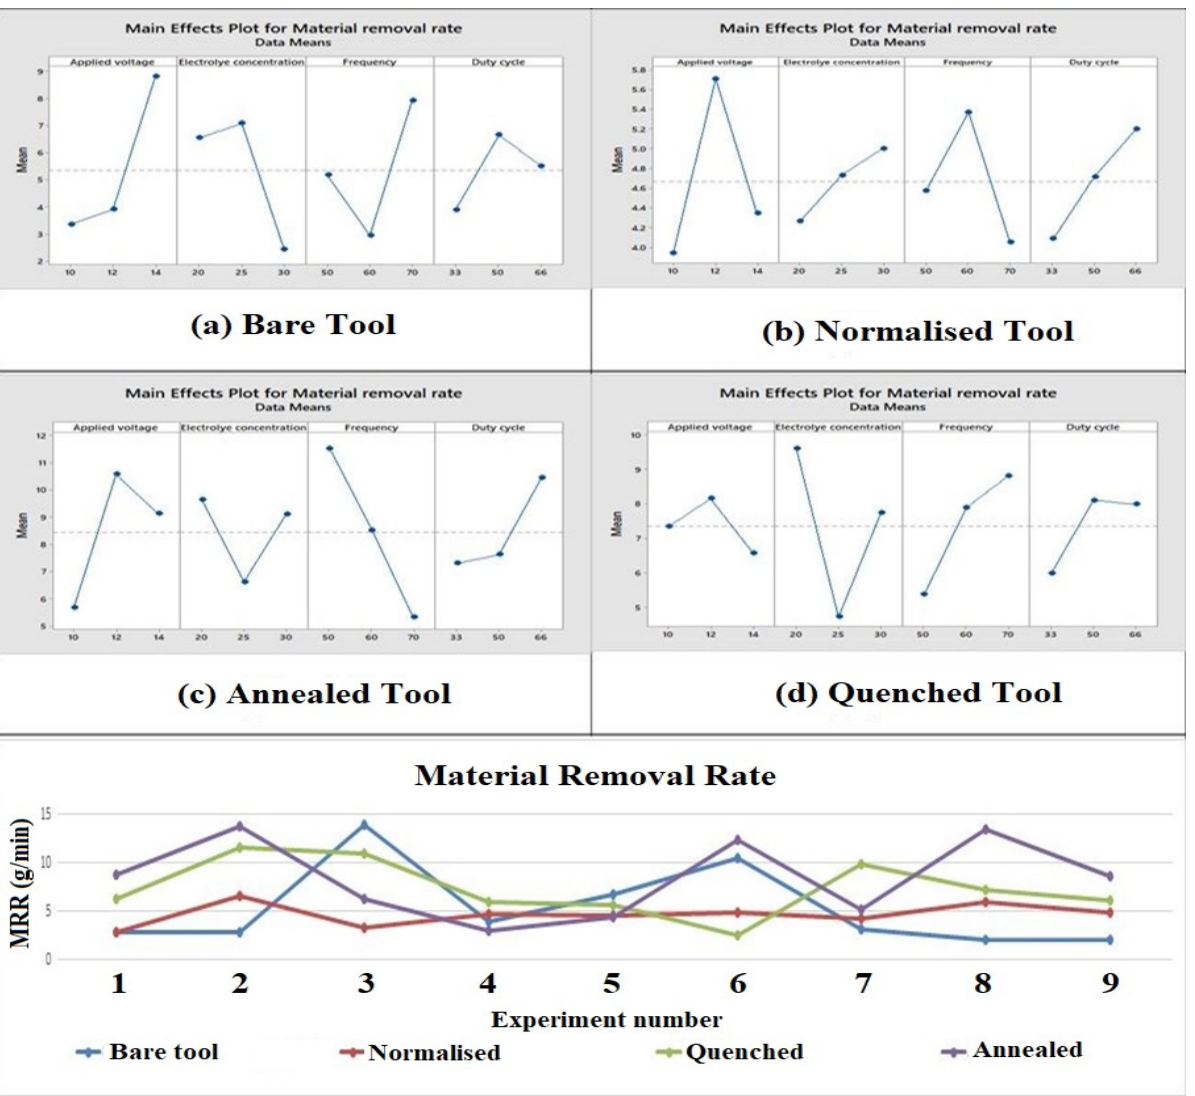
Figure 4. Main effect plots and comparison plot of MRR for tool electrodes. ( a ) Bare tool; ( b ) Normalized tool; ( c ) Annealed tool; ( d ) Quenched tool.